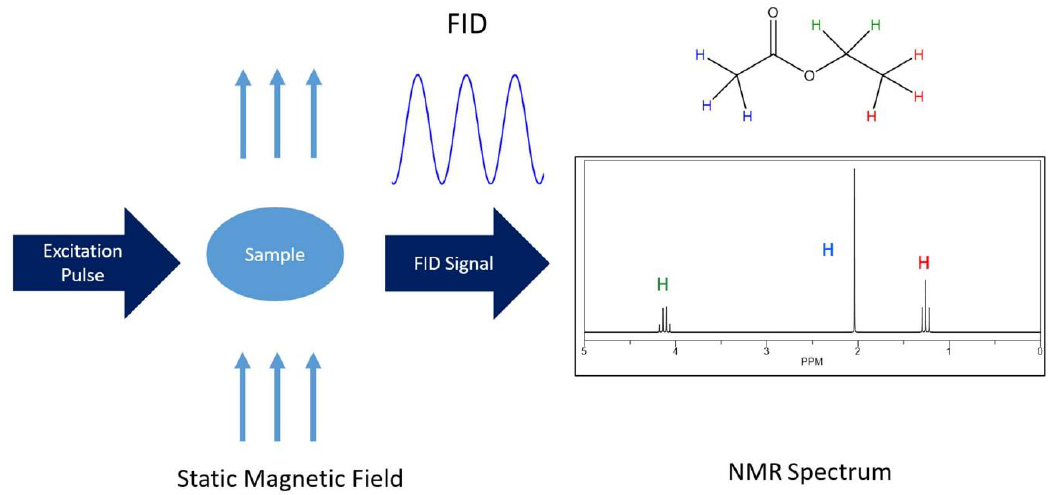
Figure 2. The most simplified layout of an NMR experiment. The NMR spectrum of ethyl acetate Table 1. H chemical shift assignments is shown as an example. The chemical structure and simulated 1 H-NMR spectrum were created using ChemDraw 18.1.